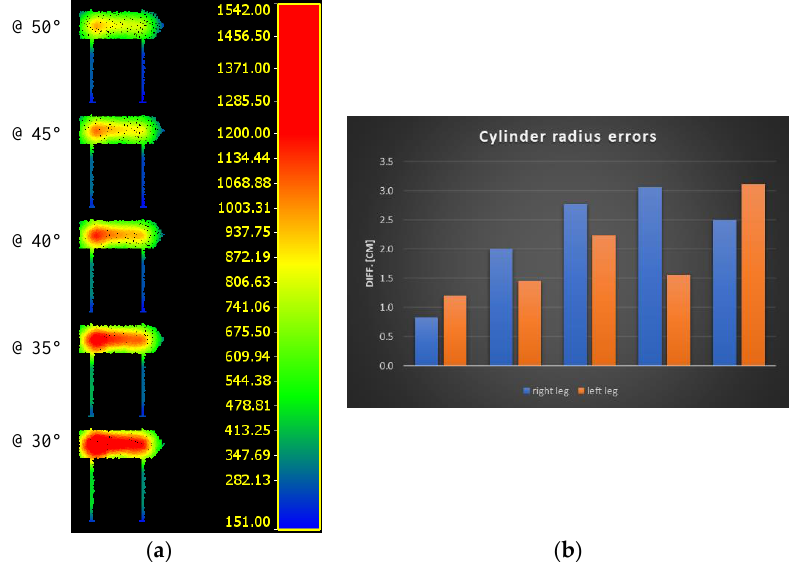
Figure 25. ( a ) Density of points at the road board sign at each tilting angle (red≥1200 pts/m 2 ). ( b ) Histogram of differences in the estimated cylindrical board legs radii.